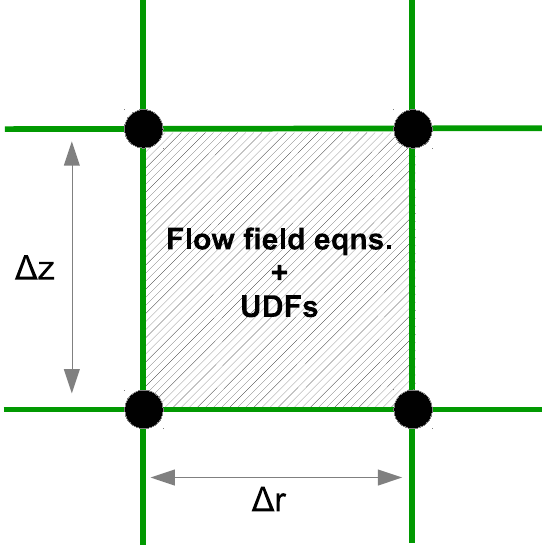
Figure 4. Individual unit cell for structured